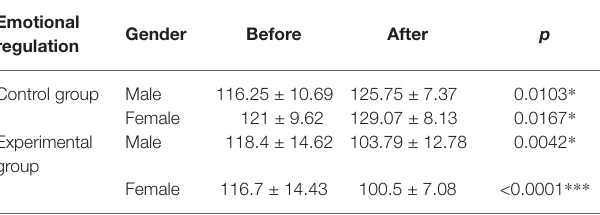
TABLE 4 | Gender differences of GIMT effect in emotional regulation. Emotional Gender regulation